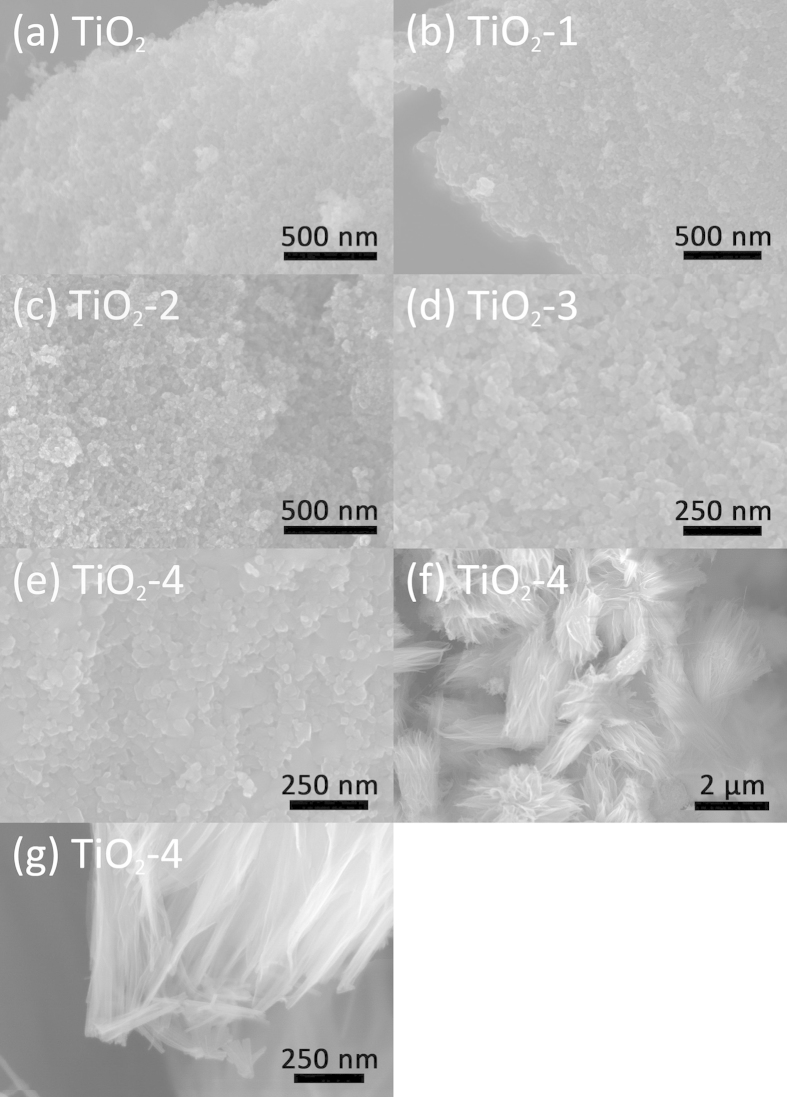
SEM images of pristine TiO2(a) and as-obtained TiO2 nanostructures: (b) TiO2-1, (c) TiO2-2, (d) TiO2-3 and (e) TiO2-4; (f) and (g) hierarchical structures TiO2-4.